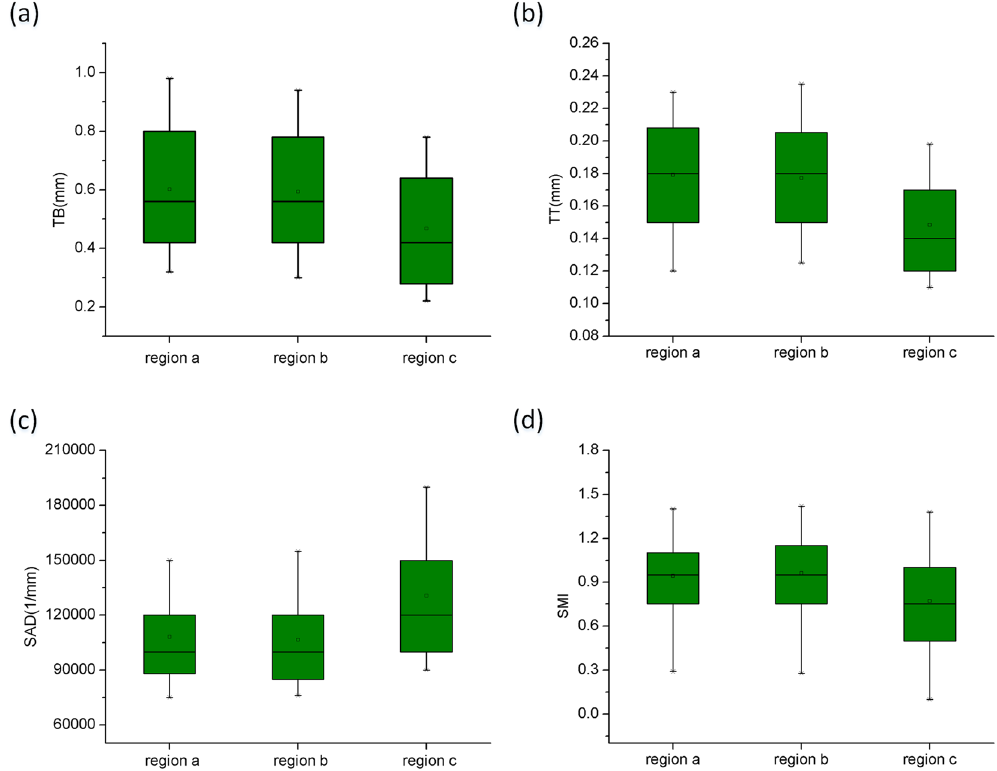
Figure 3. Finite element model used to apply boundary conditions along the three orthogonal directions. The pink arrow represents the position and direction of the displacement constraint (the constraint size is 1%), and the blue mark shows that the surface of the mark is completely